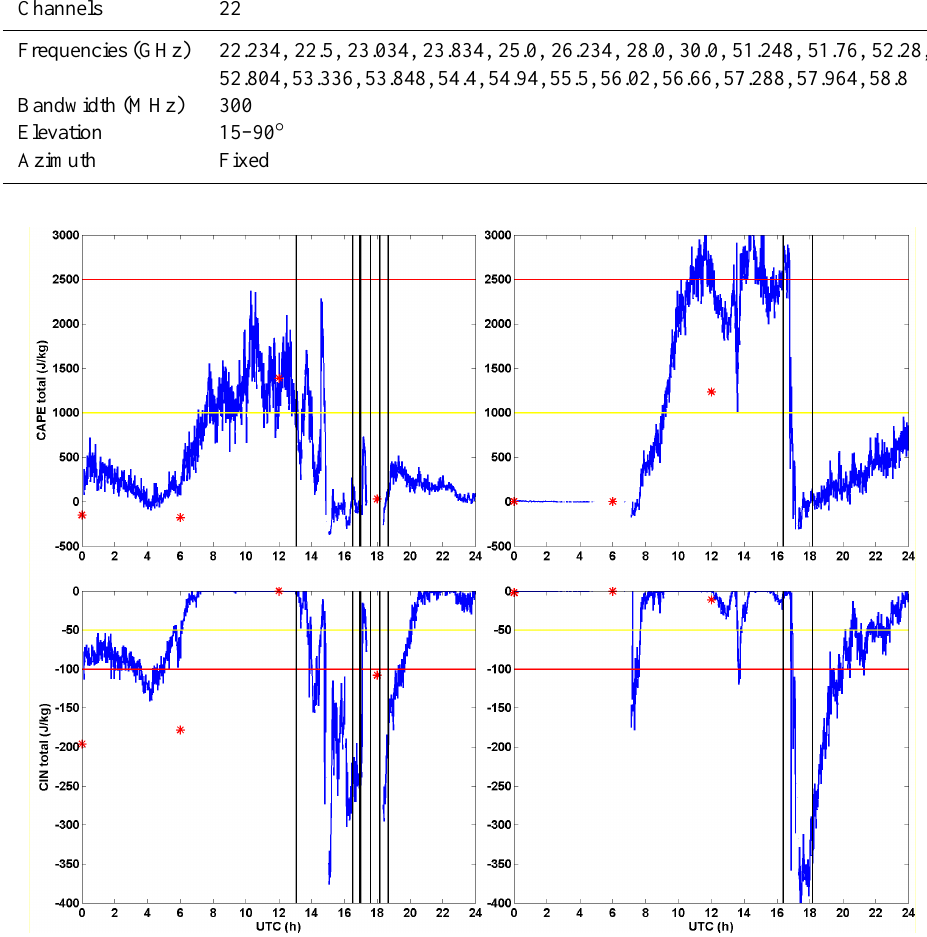
Figure 3. Same as Fig. 2 but for CAPE (top) and CIN (bottom). Yellow and red lines show the thresholds for, respectively, weak and moderate thunderstorm potential (CAPE) and convective inhibition (CIN). Left: 12 August 2010. Right: 15 August